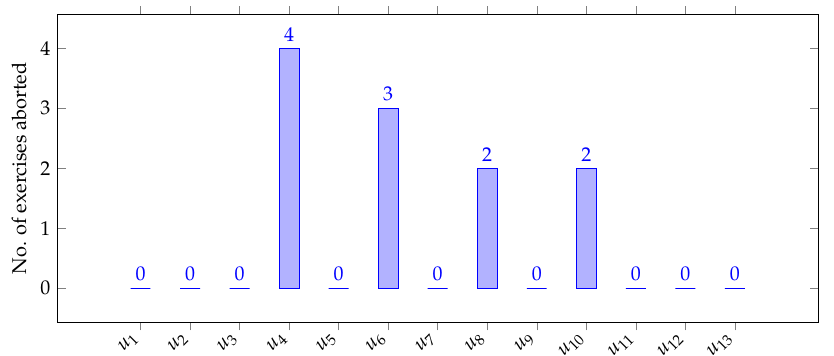
Figure 19. Number of aborted exercises per